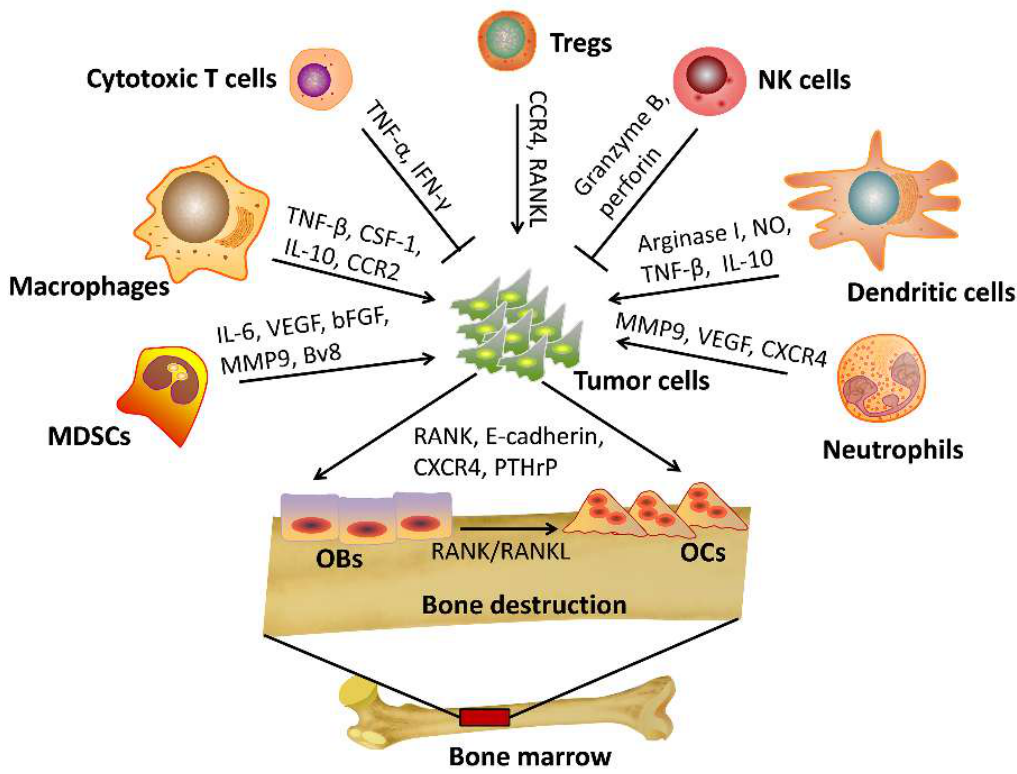
Figure 1. The interaction of immune cells and cancer cells during bone metastasis. Cytotoxic CD8 + T cells release TNF- α and IFN- γ to eliminate tumor cells. Natural killer cells (NK cells) kill tumor cells through granzyme B- and perforin-mediated apoptosis. Regulatory T cells (Tregs) promote